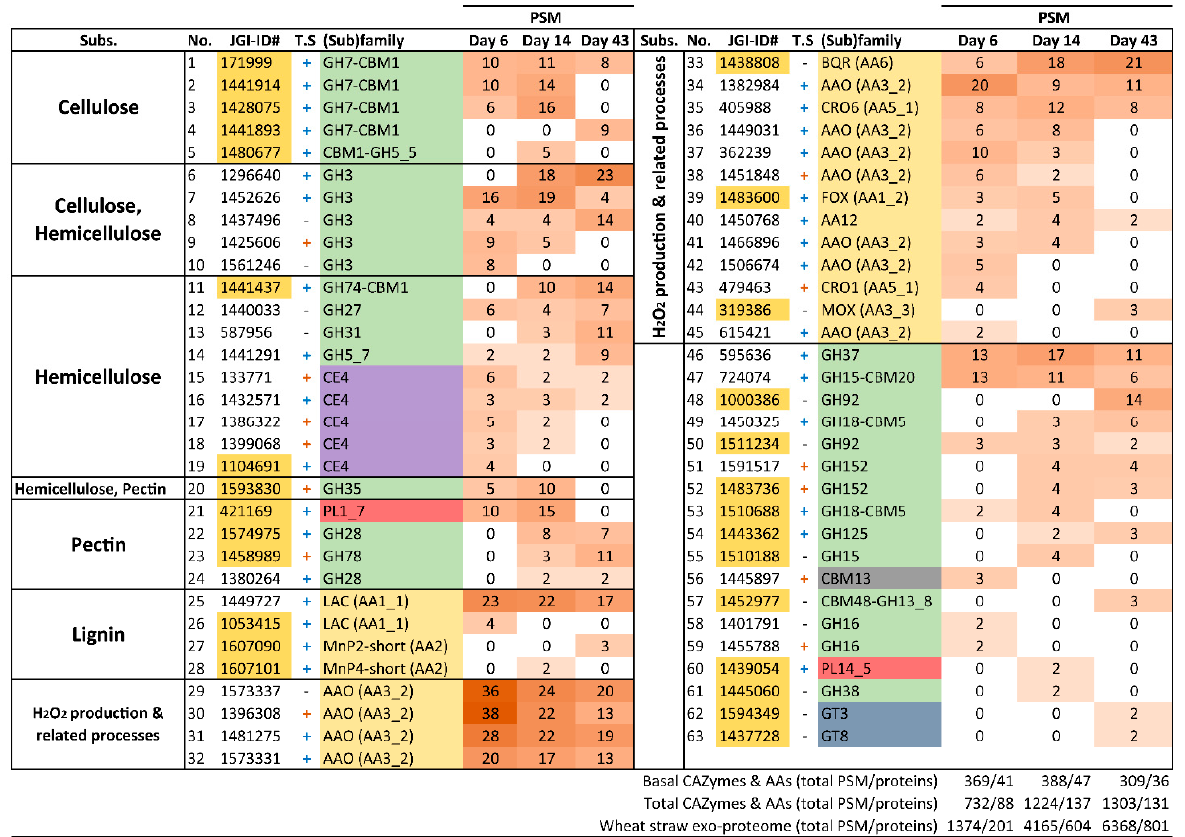
Figure 8. CAZymes and oxidoreductases (AA) transcribed at basal level identified in the wheat–straw exoproteome. The enzymes are organized according to the substrate on which they act or the process in which they participate (column “Subs”) and then sorted from highest to lowest abundance based on total PSM values. The protein reference numbers (JGI-ID#) correspond to those in the catalog of predicted proteins from the P. eryngii ATCC 90797 genome available through JGI MycoCosm Genome Portal. Protein references over yellow background correspond to enzymes exclusively secreted on wheat–straw. The presence (+) or absence (-) of theoretical secretion (T.S) is indicated. Symbol + in blue or orange color represents proteins predicted to be secreted by the classical secretory pathway or by the unconventional pathway, respectively. Enzymes 46–63 have not been related to lignocellulose degradation. Colors in the (sub)family column correspond to: GH, green; oxidoreductases, yellow; PL, red; CE, purple; GT (glycosyl transferase), blue; and CBM, gray.